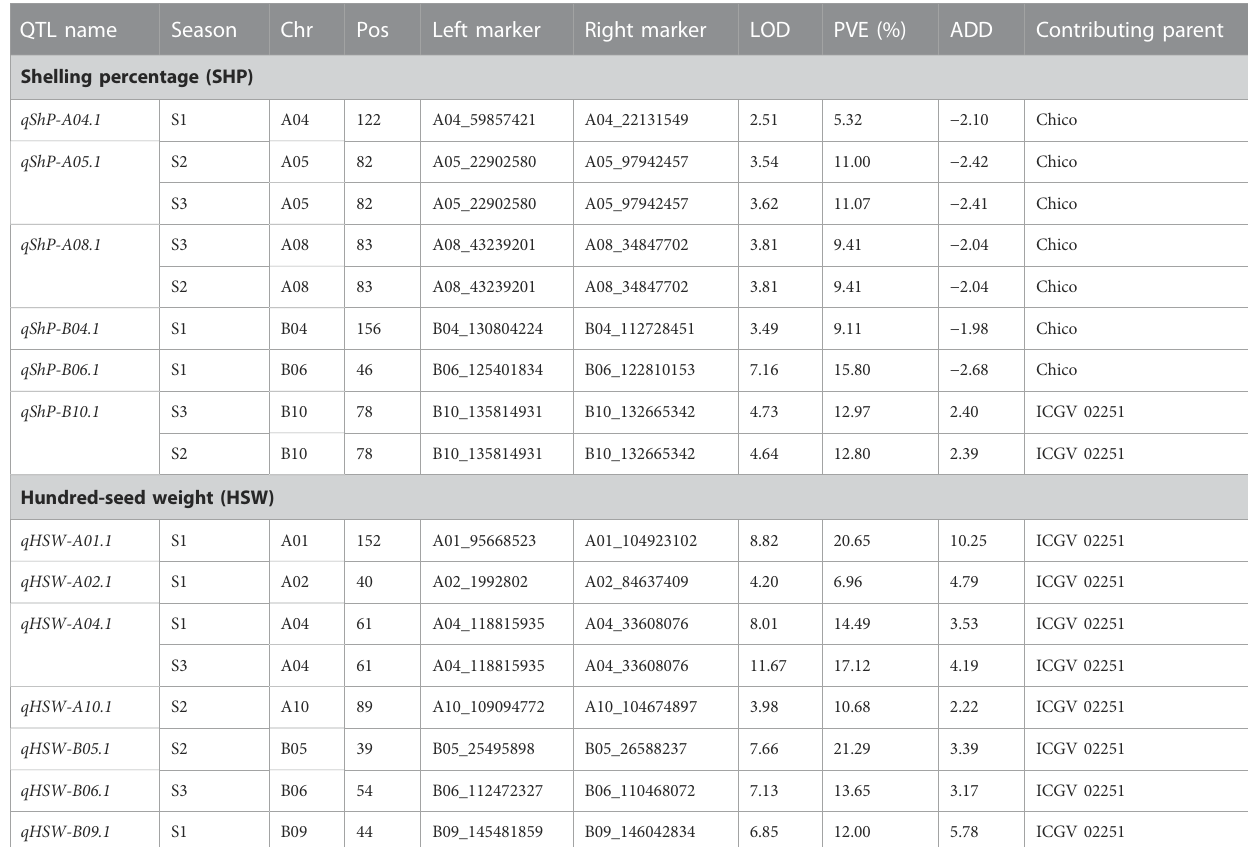
TABLE 2 Main effect of QTLs for hundred-seed weight and shelling percentage. QTL